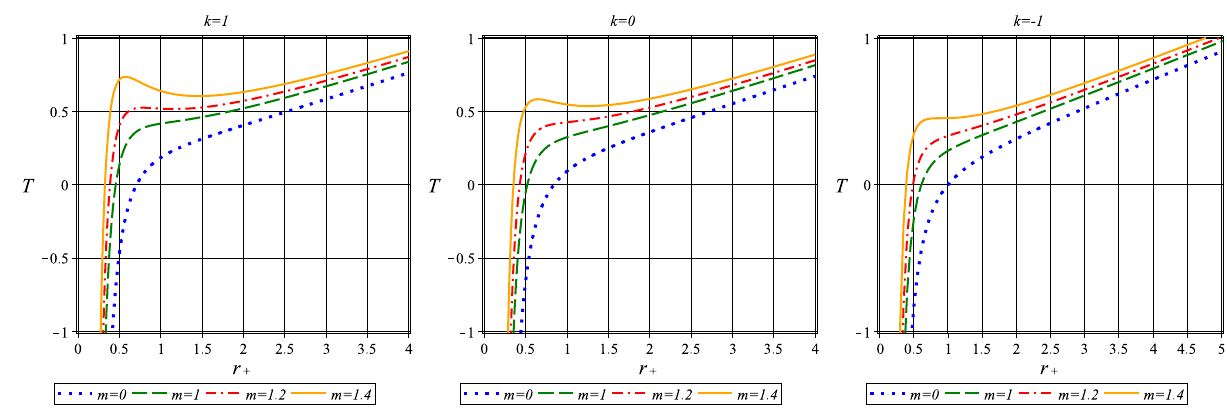
Fig. 6 Temperature of the second model (Eq. (3.16)) in terms of horizon radius, for ξ = 1 and ε = 1 (unit value for other parameters)